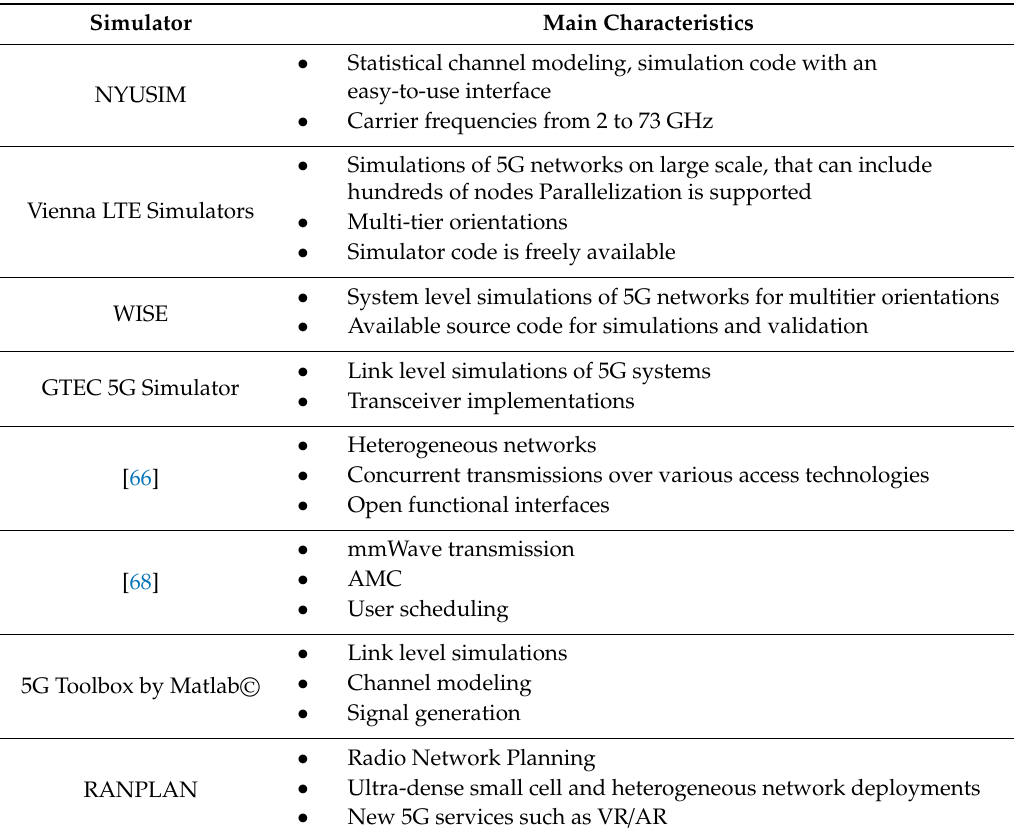
Table 2. Summary of the most significant 5G